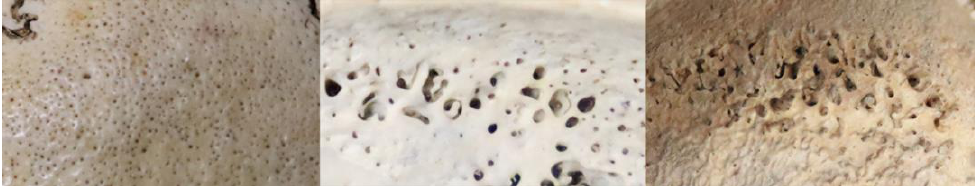
Figure 2. Different severity scores of porotic lesions (left: score 1, middle: score 2, right: score 3). Table 3. Severity scores in the “reduced” migrant sample of 25 individuals and non-migrant sample (% refer to percentages of affected individuals).